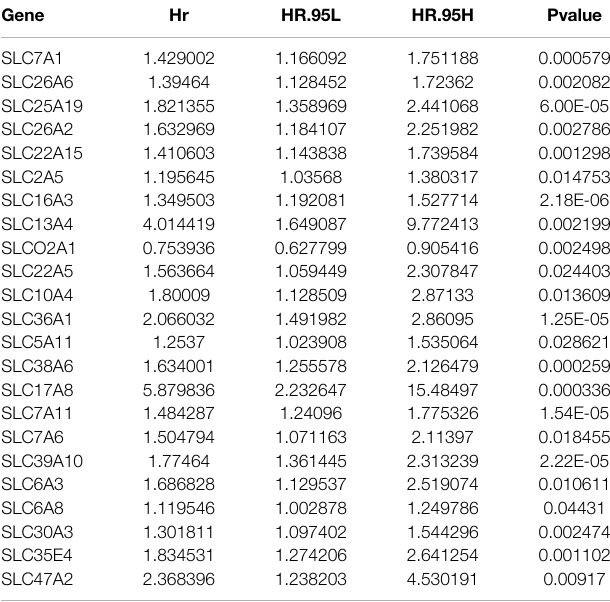
TABLE 2 | Univariate Cox regression was performed to screen SLC genes associated with